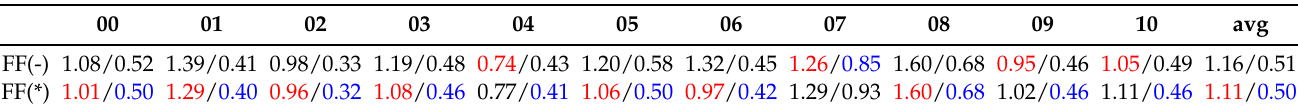
Figure 26. ( a ) The sample images in our campus dataset with moving vehicle. ( b ) The trajectories of LiDAR-based odometry and direct visual-LiDAR fusion odometry. ( c ) Edge points extracted in LiDAR point cloud, they are more likely to be located at the boundary of objects. Table 7. Translation error [%]/rotation error [deg/100 m] comparison of the different salient points selection trajectories in direct frame-to-frame visual-LiDAR odometry. Best results in translational error/rotational error are highlighted in red and blue,